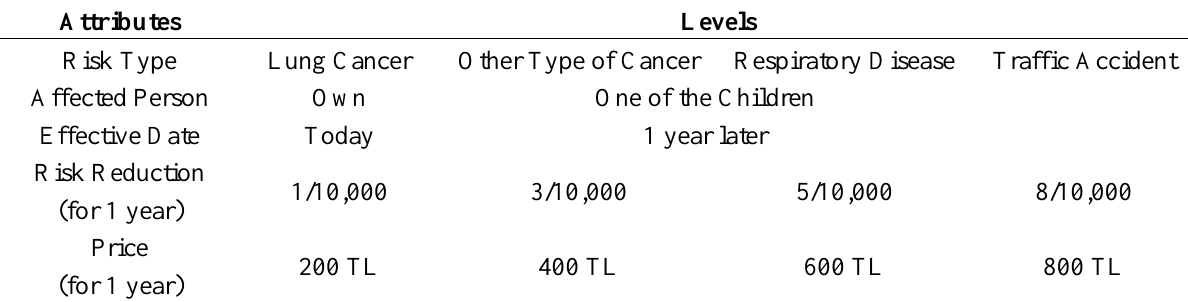
Table 1. Description of Attributes for CE